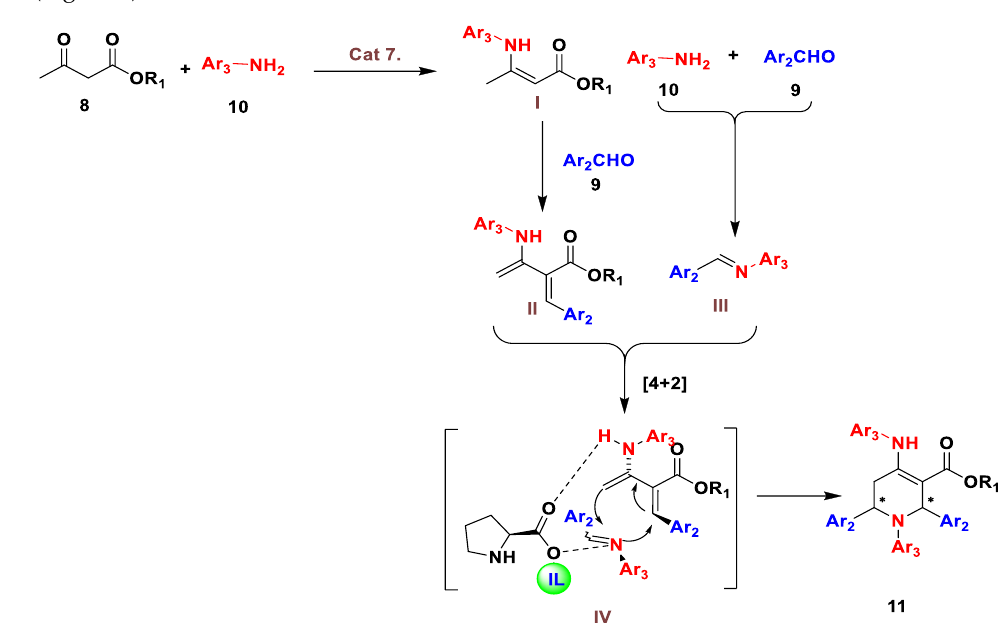
Figure 3. Plausible reaction mechanism of tetrahydropyridines.